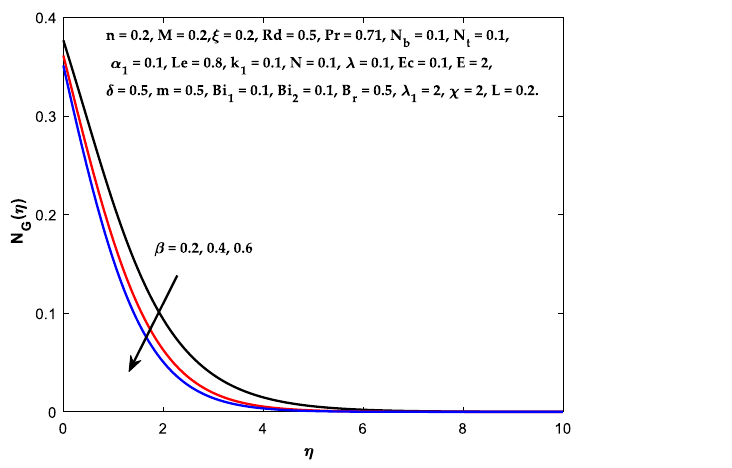
Figure 23. Diagram of β v/s N G (η) .